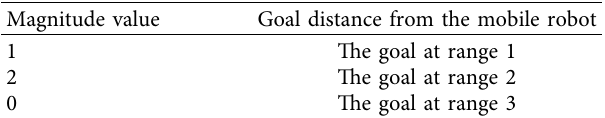
Table 4: Sample input values from the IP camera used in ANN to identify the goal location with respect to the recent mobile robot location referring to the defined ranges in Table 2.